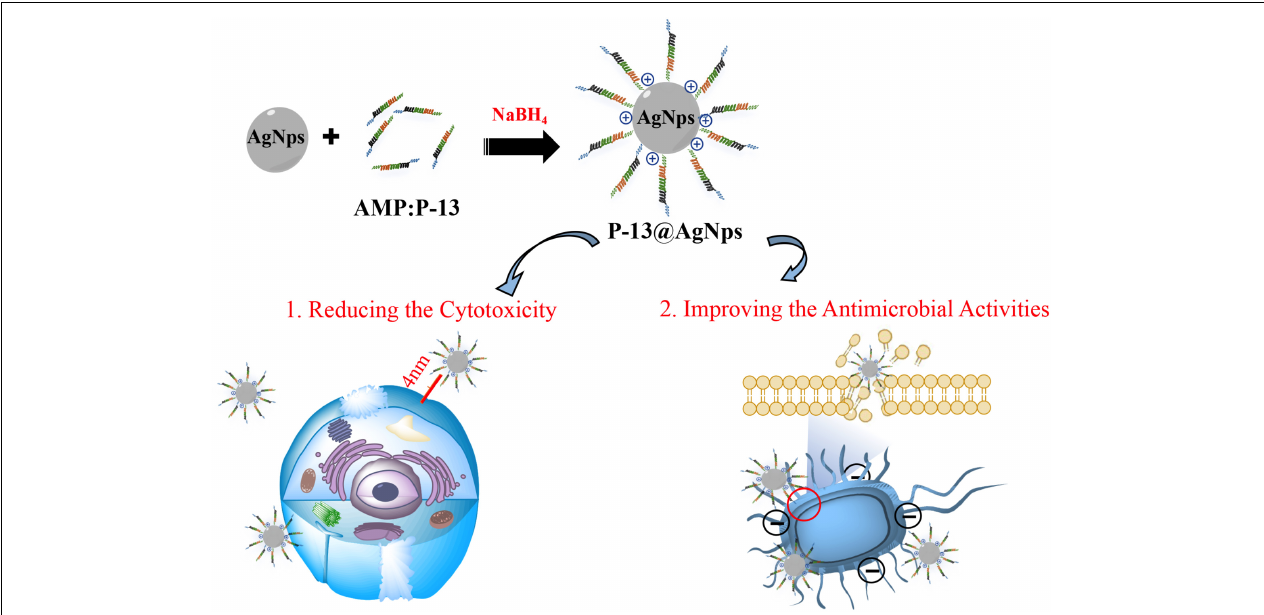
FIGURE 3 | Mechanisms for antimicrobial properties of P13@silver nanoparticles (AgNPs) (cytotoxicity and antimicrobial activity). The peptide P13 increases the distance between AgNPs and cells, which significantly reduces the cytotoxicity. Meanwhile, the peptide P-13 improves the cationic on the surface of AgNPs, promoting the interaction of P-13@AgNPs with bacteria membrane, causing the death of microbes.